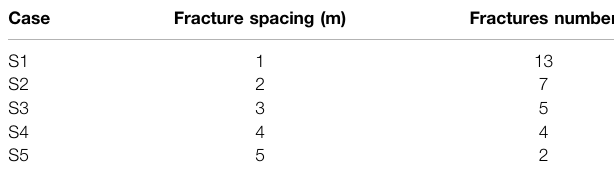
TABLE 4 | Fracture spacing and corresponding calculation case.